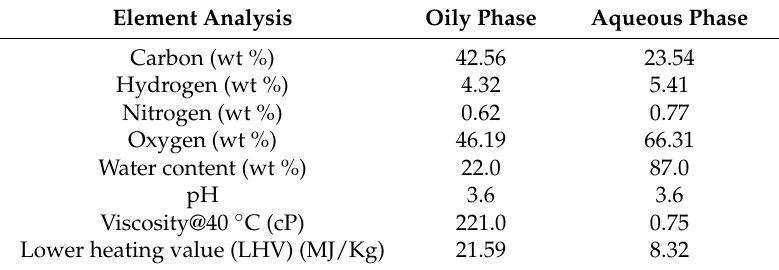
Table 1. Properties of the oily phase and aqueous phase of FPBO (Fast pyrolysis bio-oil). Element Analysis